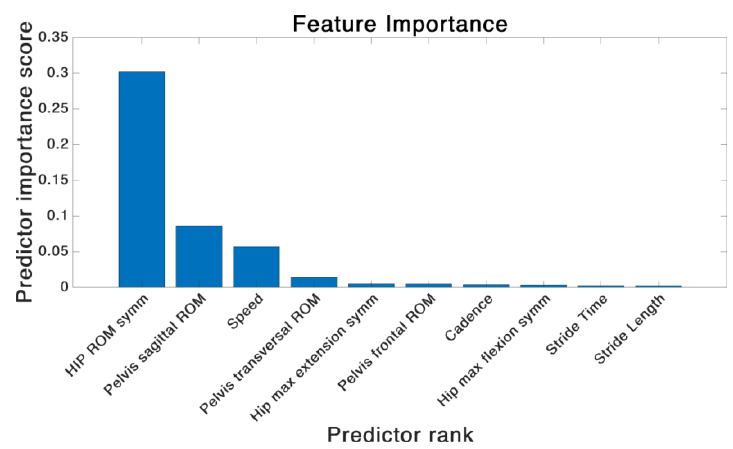
Figure 8. Ranking of the combined features from Set 1 and 2 based on IMU data after employing a minimum redundancy maximum relevance (MRMR) feature ranking algorithm.